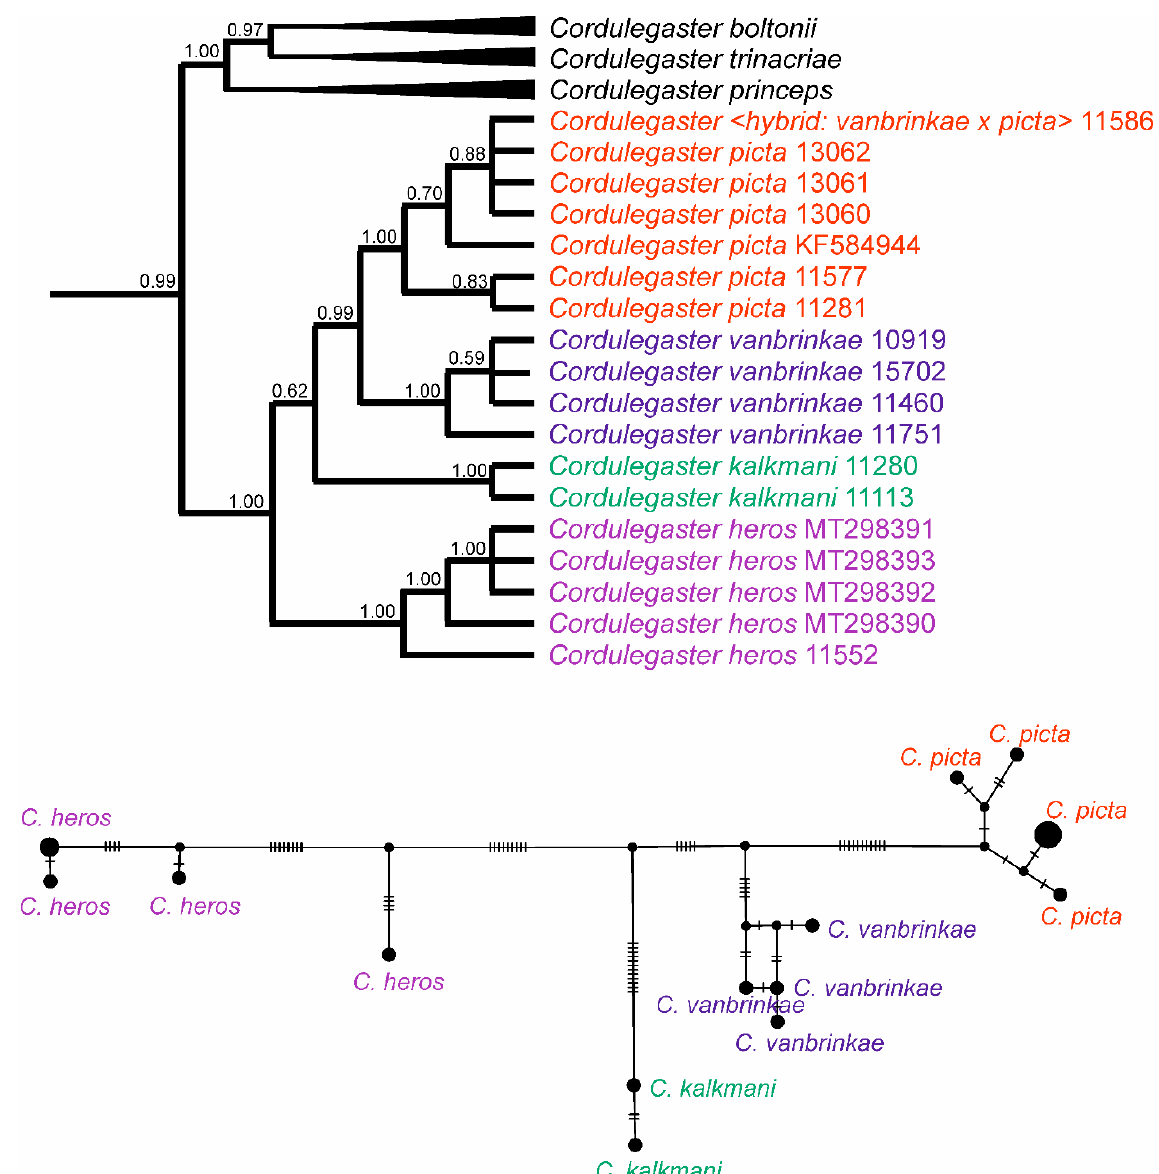
Figure 6. Tree of the COI-analysis for the C. boltonii -group and haplotype-analysis (TCS-network made in POPART 1.7). Bayesian posterior probability values are depicted at the nodes.